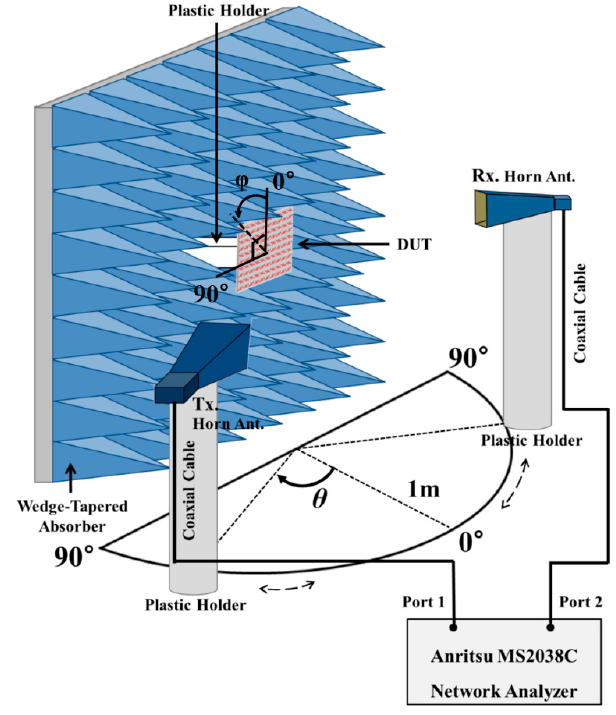
Figure 7. Illustration of the measurement environment.